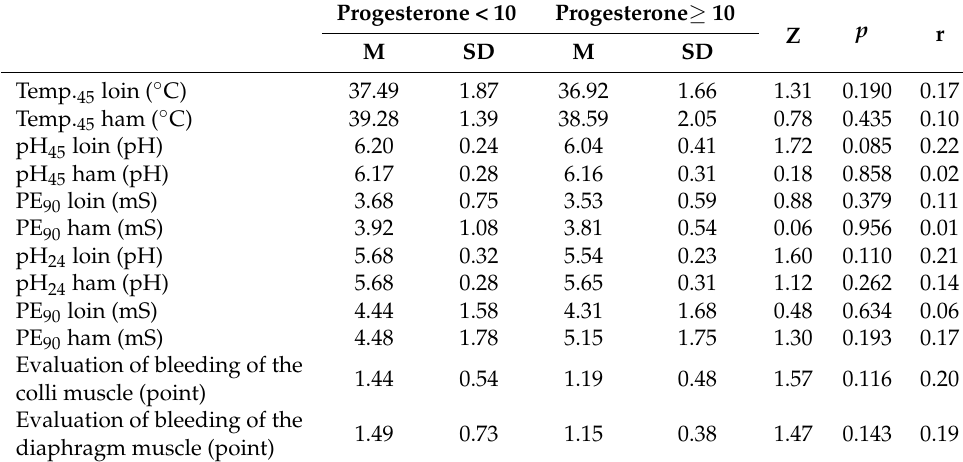
Table 3. Influence of progesterone level (ng/mL) on selected quality parameters of gilts meat.